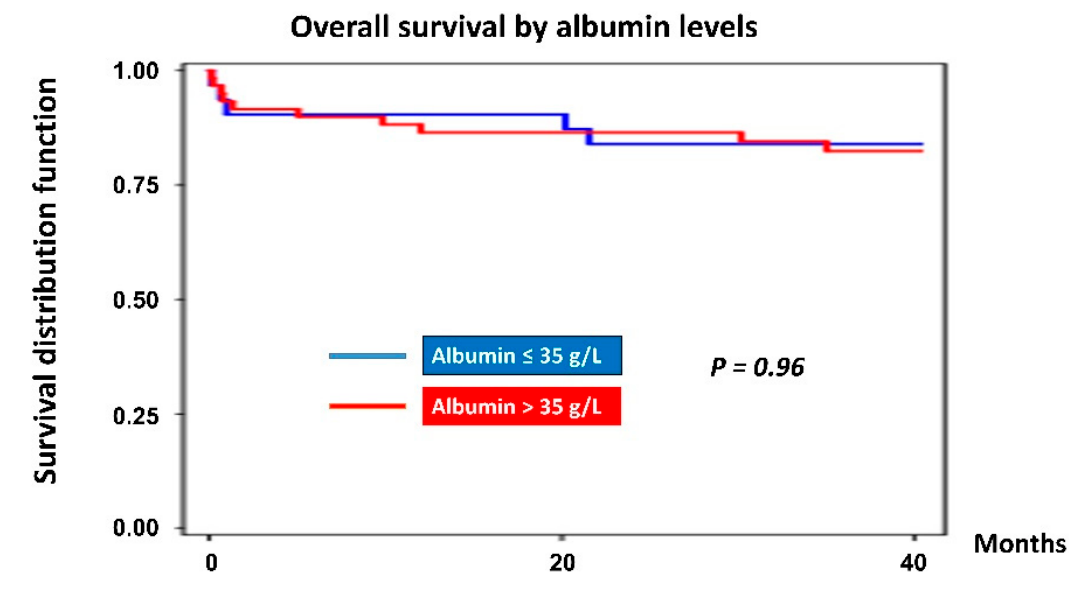
Figure 6. Kaplan–Meier graph of overall survival by albumin level. Table 4. Cox proportional hazards regression analysis of some characteristics of